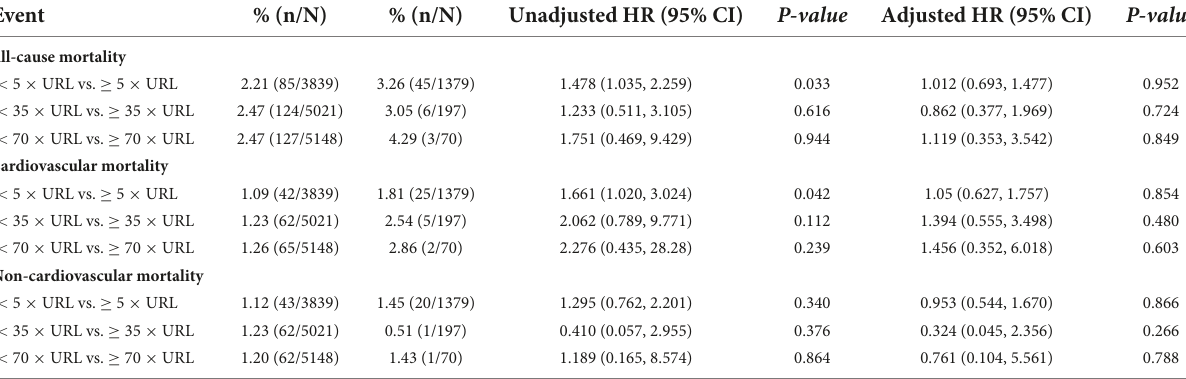
TABLE 3 Hazard ratios for 3-year mortality in patients with different post-PCI peak cTnI values according to the biomarker criterion of the 4th UDMI, ARC-2, and SCAI